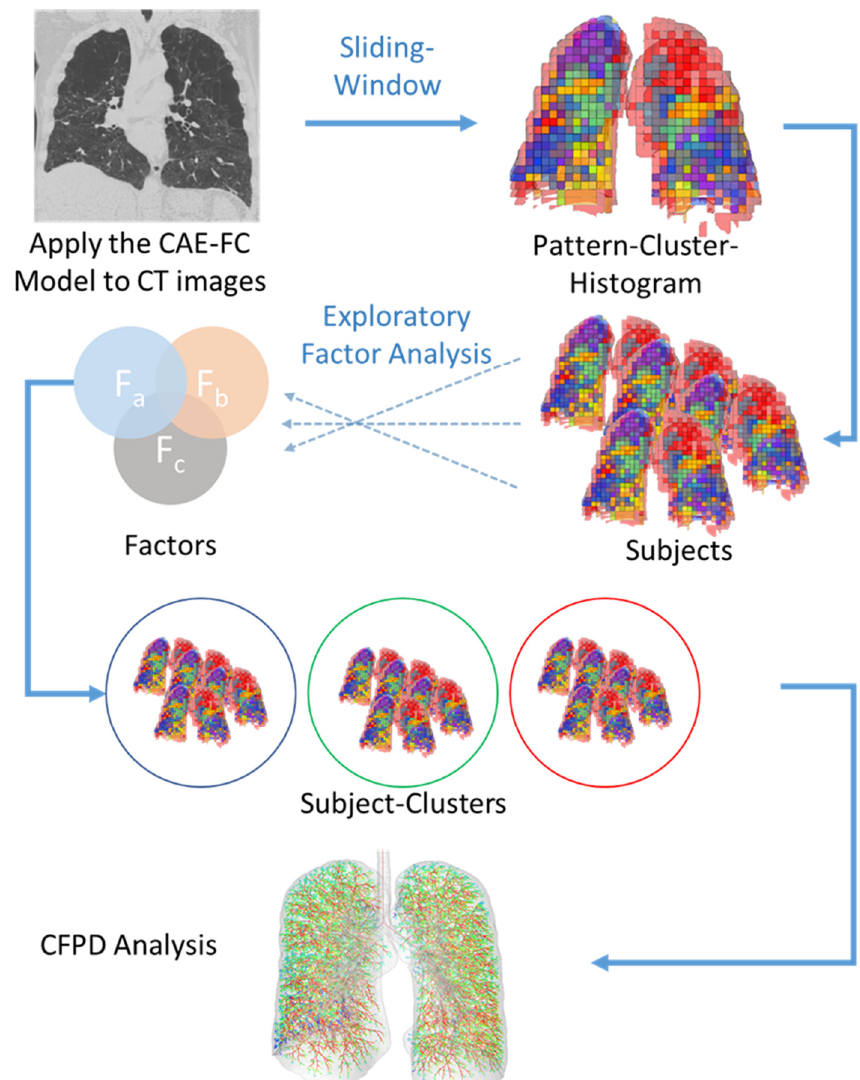
Figure 2. The CAE-FC model is applied to the ROIs extracted by the sliding window technique so as to classify the lung tissue patterns and construct a pattern cluster histogram for each subject. EFA is then used to extract the latent traits (factors) from the pattern cluster histograms of the subjects. Using the factor scores, subject clusters are identified by the k-means clustering technique. Finally, CFPD analysis is conducted to evaluate the particle depositions of the representative subjects.